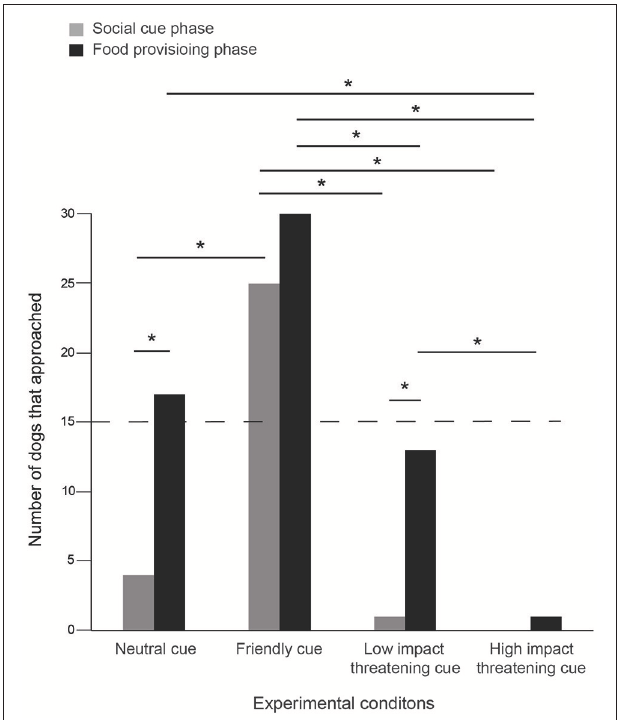
FIGURE 2 | Percentage of distant position out of “no approach.” Bar graph showing the percentage of dogs that showed distant position out of “no approach” in the SCP and FPP of LIT and HIT conditions. Dogs showed significantly more distant positions in both the SCP compared to FPP of LIT (Goodness of fit χ 2 : χ 2 = 10.316, df = 1, p = 0.001) and HIT (Goodness of fit χ 2 : χ 2 = 6.644, df = 1, p = 0.01) conditions. Asterisks indicated significant